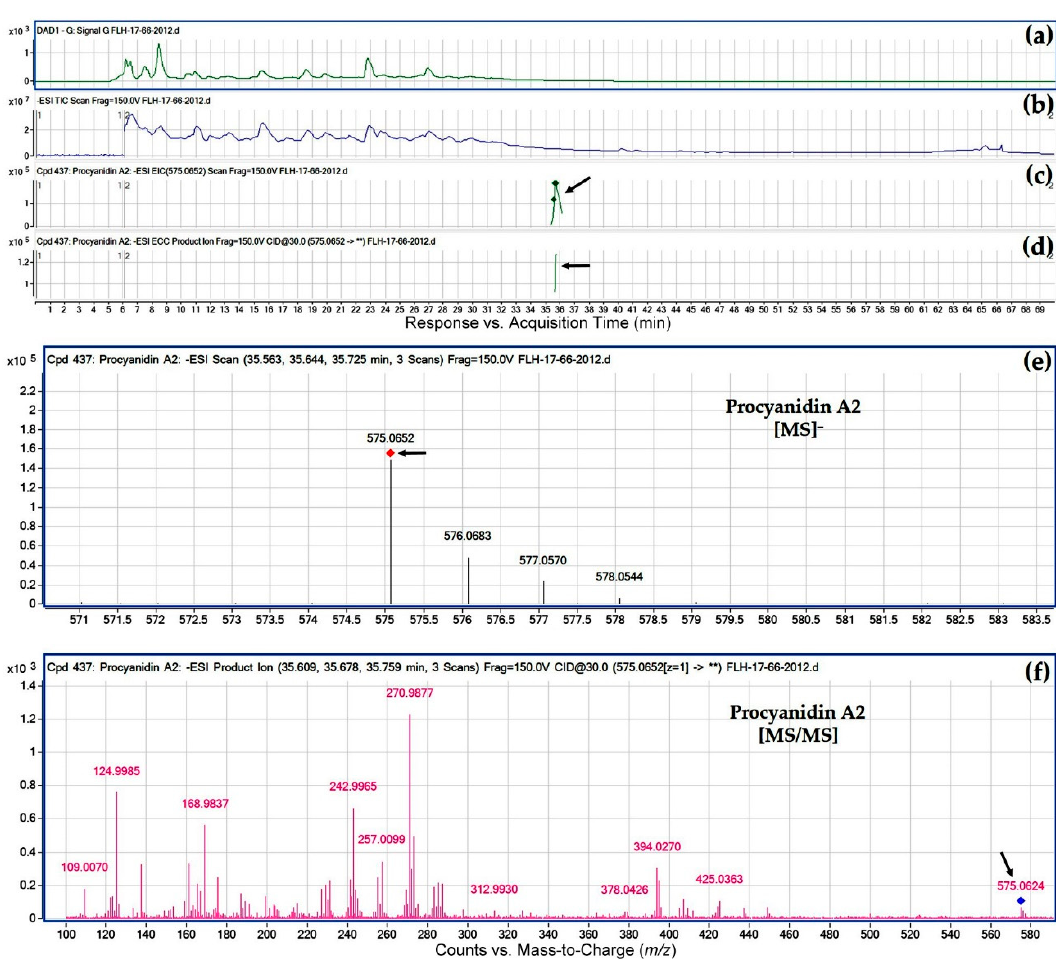
Figure 9. Extracted ion chromatogram (EIC) of primary mass spectrum (MS1) and m / z features of secondary ion fragments (MS2) derived from LC-MC/MS annotate this peak to be procyanidin A2 (MW, 576.51). ( a ) Chromatogram of FLH 17-66 extract (2012) recorded at 280 nm; ( b ) total ion chromatogram of FLH 17-66 extract (2012); ( c ) EIC of primary ion 575.0652 [M − H]¯; ( d ) enhanced charge capacity (ECC) ion product for 575.0652 m / z ; ( e ) A MS profile showing an extracted m / z value, 575.0652; and ( f ) fragments from collision-induced dissociation (CID) of m / z 575.0652 showing m / z 109.0070, 124.9985, 136.9988, 152.9935, 168.9837, 242.9965, 270.9877, 285.0011, 296.9985, 327.0119, and 425.0363 (Table 1).